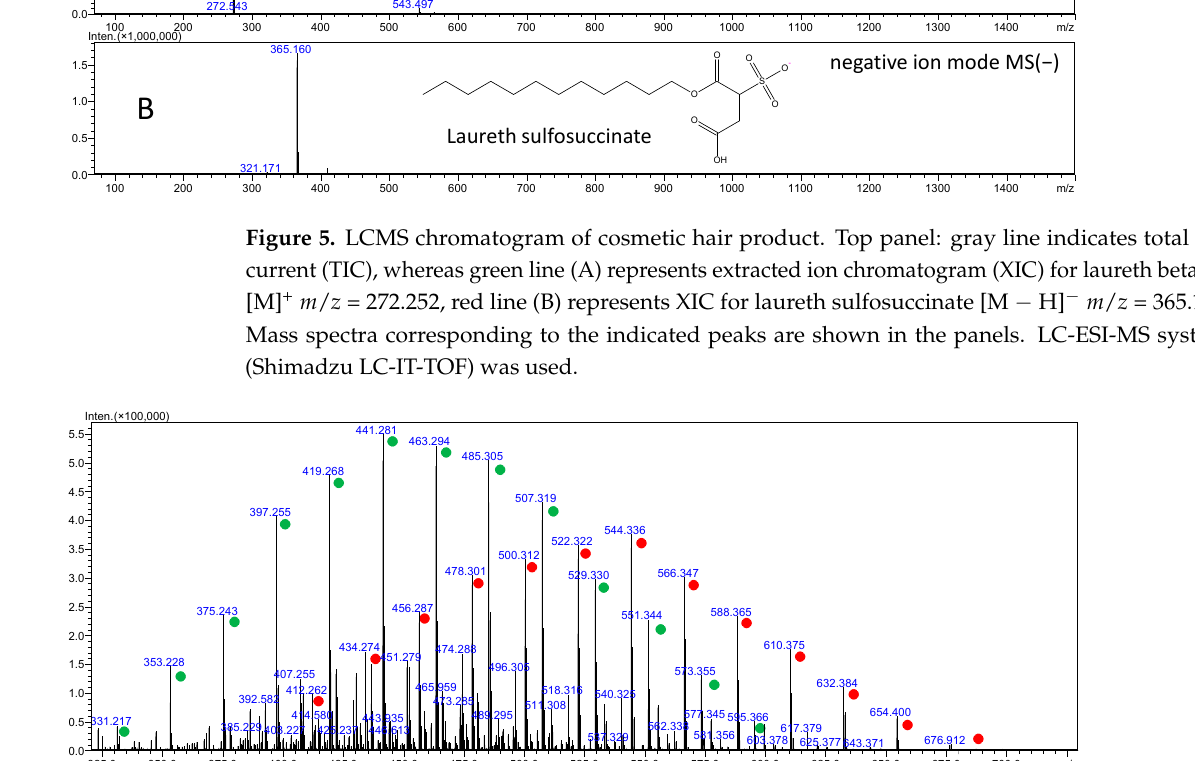
Figure 6. Mass spectrum averaged for 0.1 min time period of LCMS chromatogram of facial moisturizing toner, containing PEG/PPG-17/6 copolymer. Green dots indicate a series of protonated ions [M + 2H] 2+ consisting of 5 PPG units and 8–20 PEG units (PEG/PPG (8–20)/5), whereas red dots indicate PEG/PPG (17–29)/4. LC-ESI-MS system (Shimadzu LC-IT-TOF) was used.